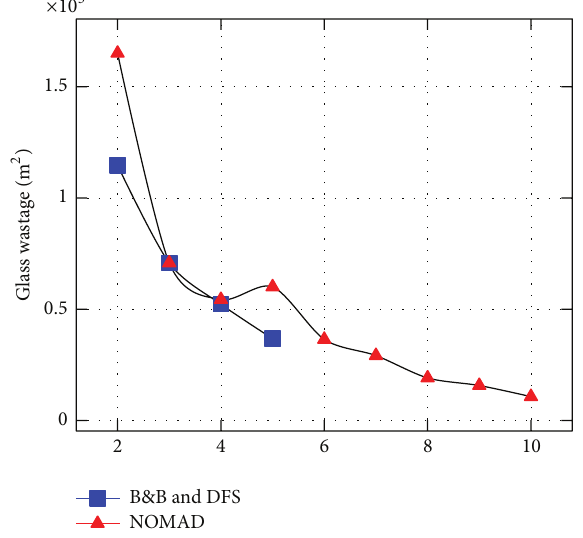
Figure 11: Glass wastage versus number of blanks